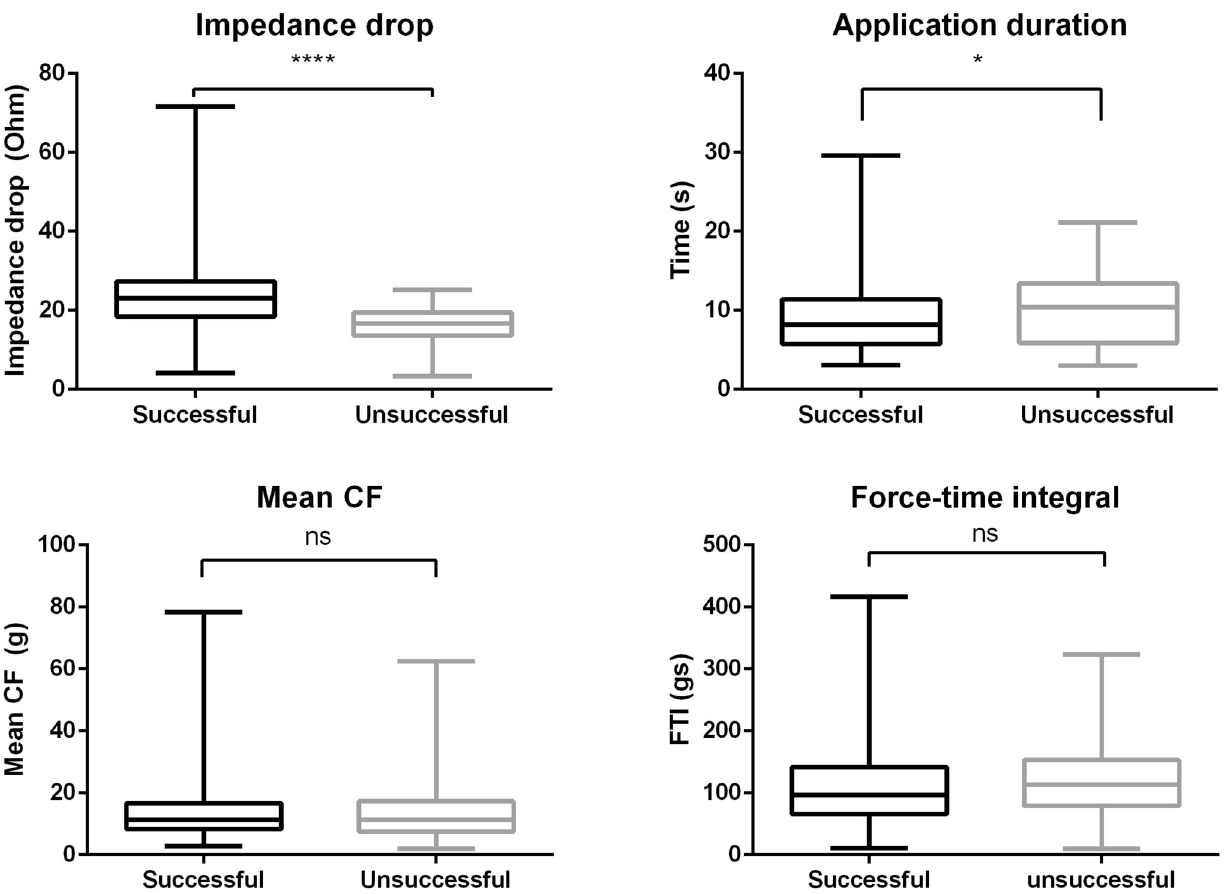
Fig 2. Impedance drop, application duration, mean contact force, and force-time integral parameters of the successful and unsuccessful lesions. Abbreviations: CF = contact force, FTI = force-time integral, � = p < 0.05, ���� p < 0.0001, ns = p � 0.05.